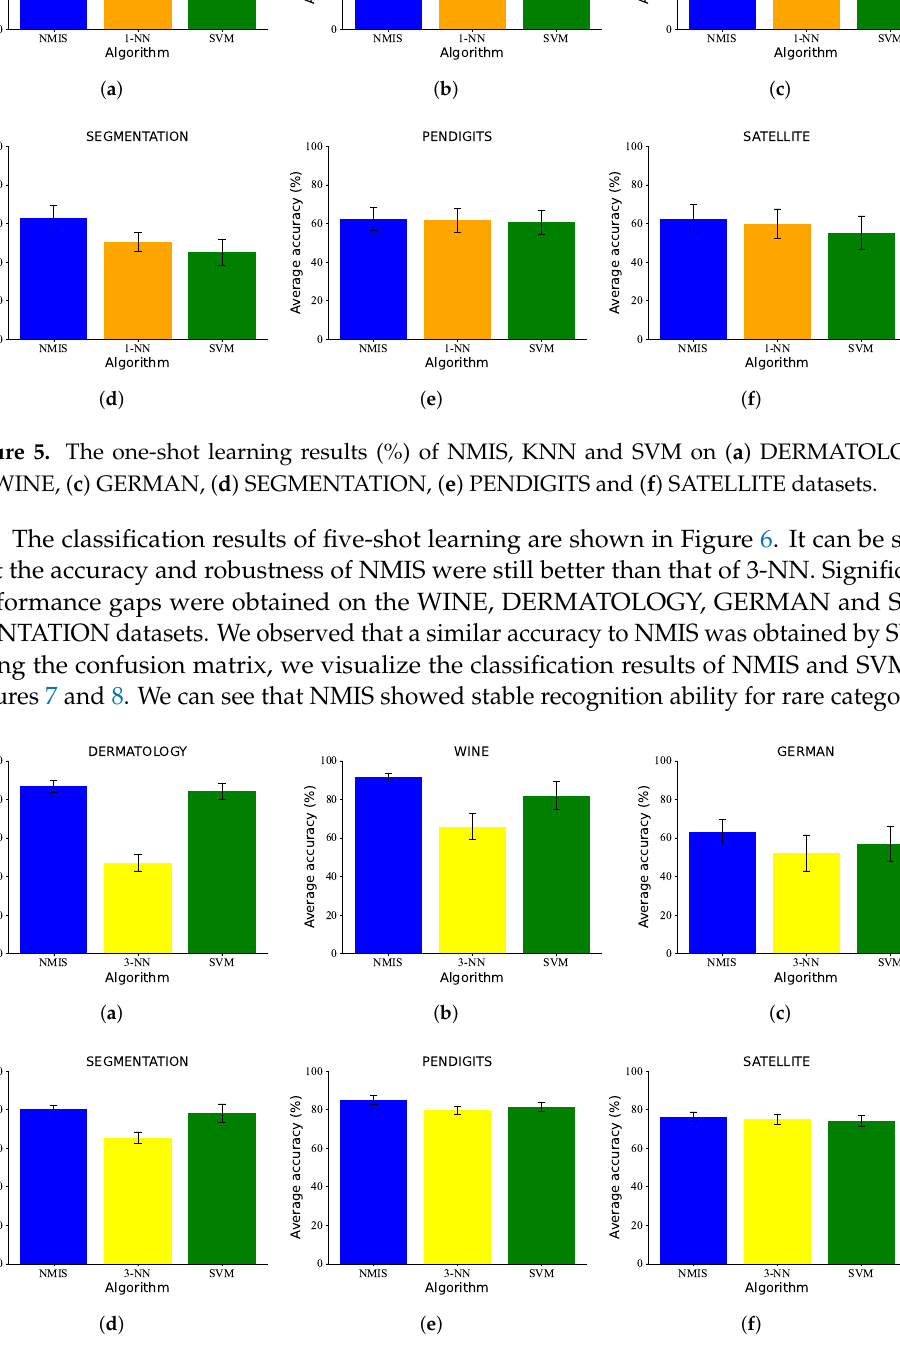
Figure 6. The five-shot learning results (%) of NMIS, KNN and SVM on ( a ) DERMATOLOGY, ( b ) WINE, ( c ) GERMAN, ( d ) SEGMENTATION, ( e ) PENDIGITS and ( f ) SATELLITE